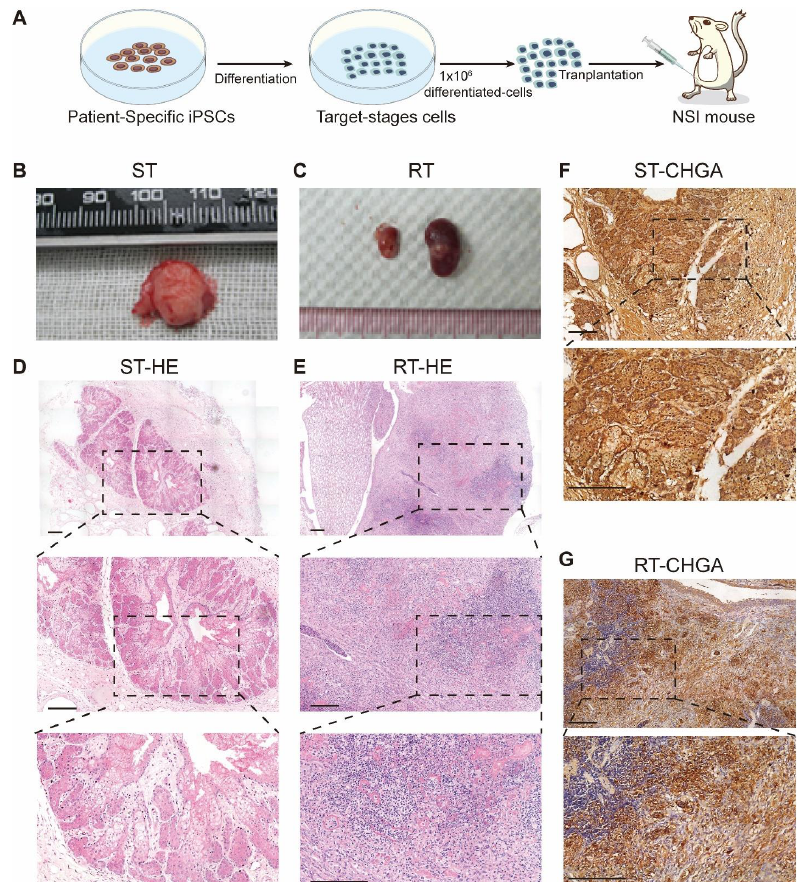
Figure 6. Transplantation of MEN-IPCs into NSI mice generated tumor similar as the original tumor from the patient. ( A ) The illustration of cell transplantation process. ( B ) The photograph of the tumor generation from SON-IPCs after 76 days of subcutaneous transplantation, marked as ST. ( C ) The tumors produced from subrenal capsular transplantation of SON-IPCs after 56 days, marked as RT. Hematoxylin and eosin staining for ST ( D ) and RT ( E ). ( F ) and ( G ) Immunohistochemical analysis of CHGA (PNETs biomarker) on tumors generated after transplantations ; Scale bar, 200μm.